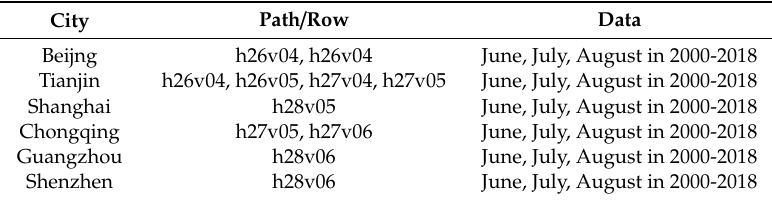
Table A2. Details of MODIS